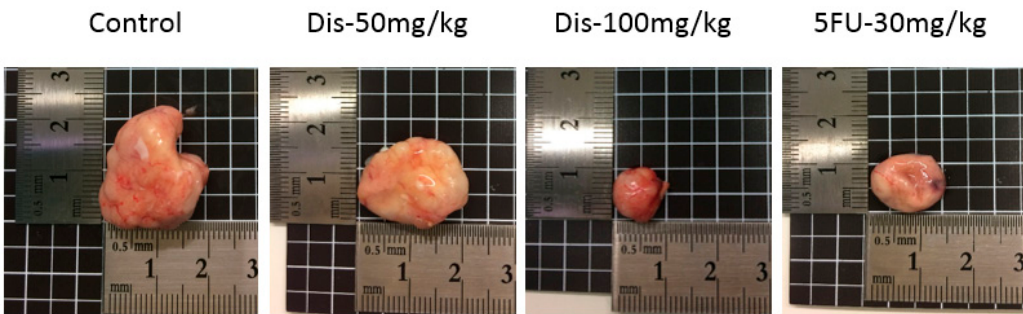
Figure 2. Tumor size of treated and untreated groups. Dis reduces the tumor size dose-dependently. 5-fluorouracil was used as a positive control.